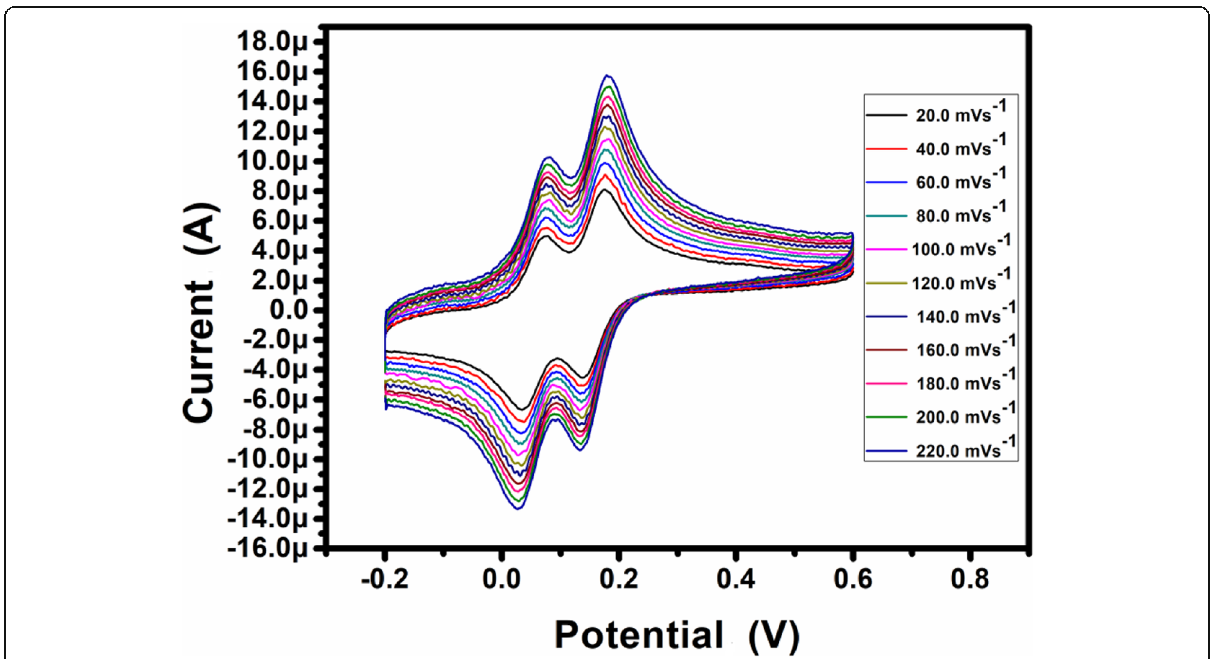
Fig. 5 CVs on impact of scan rates on electrooxidation of equimolar (40.0 μ M) binary mixture of CC and HQ at ALR/GCE with 0.2 M buffer of pH